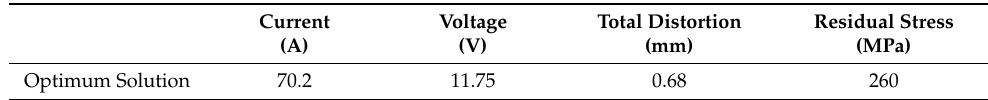
Table 4. The optimum